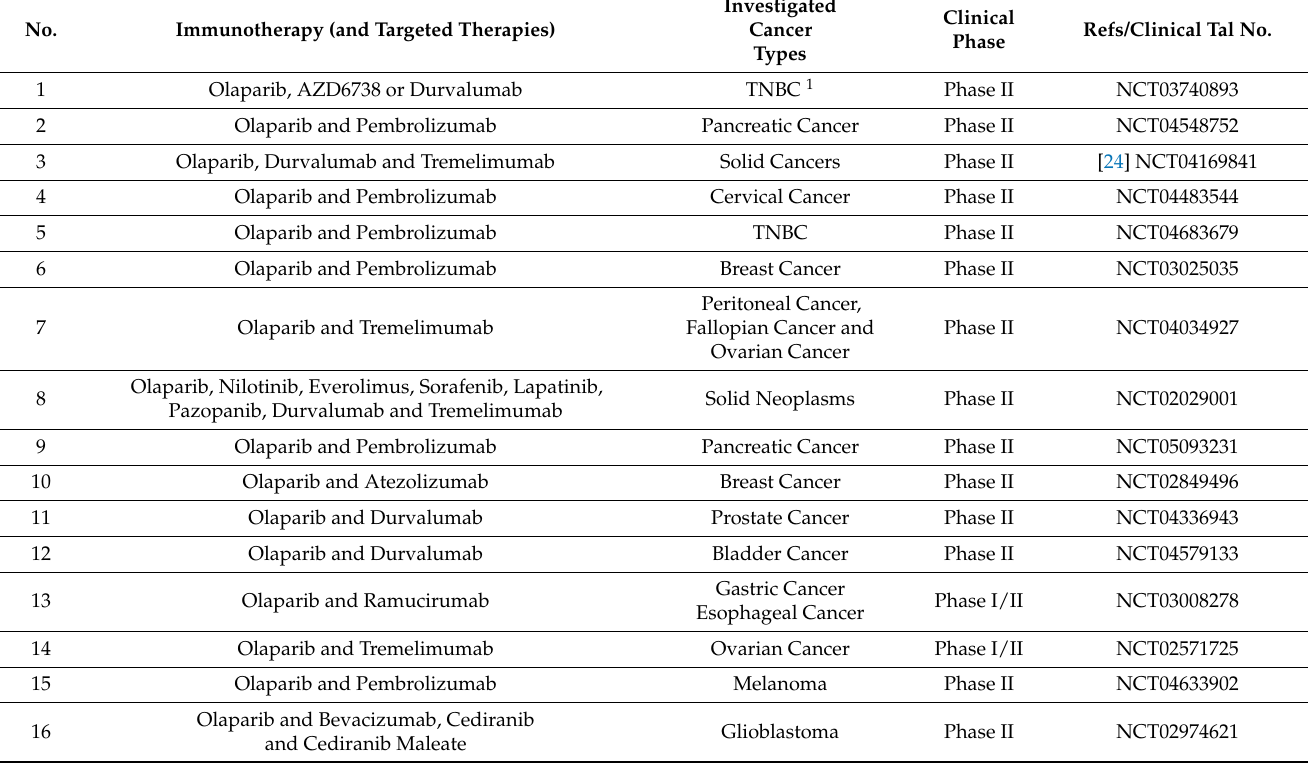
Table 1. 16 clinical trials on combinations of olaparib and various immunotherapies; some studies include additional targeted